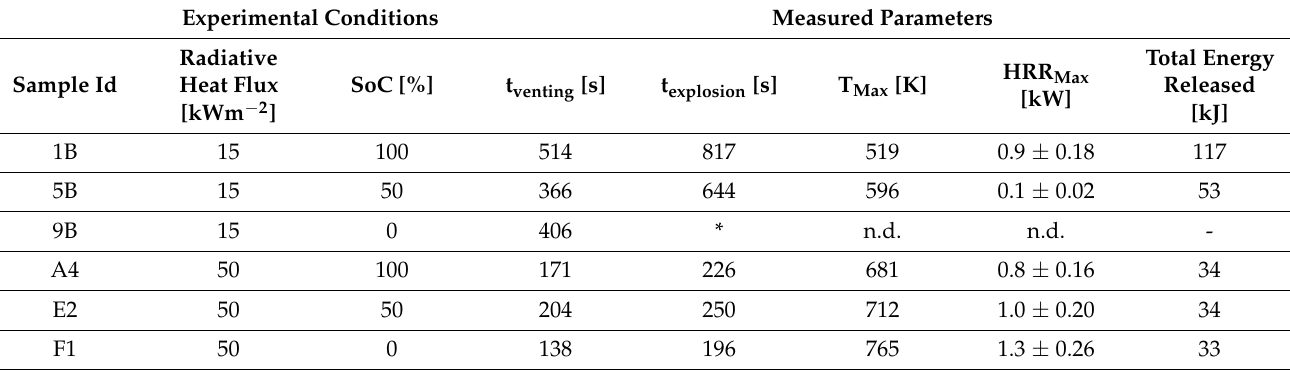
Table 1. Experimental test conditions and measured